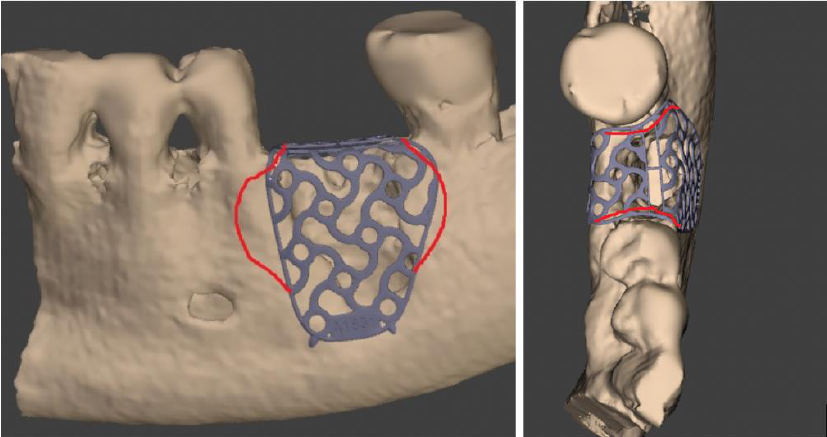
Figure 1. These screenshots show all the customized Ti mesh changes shared between the surgeon and the digital technician in the pre-clinical digital planning.